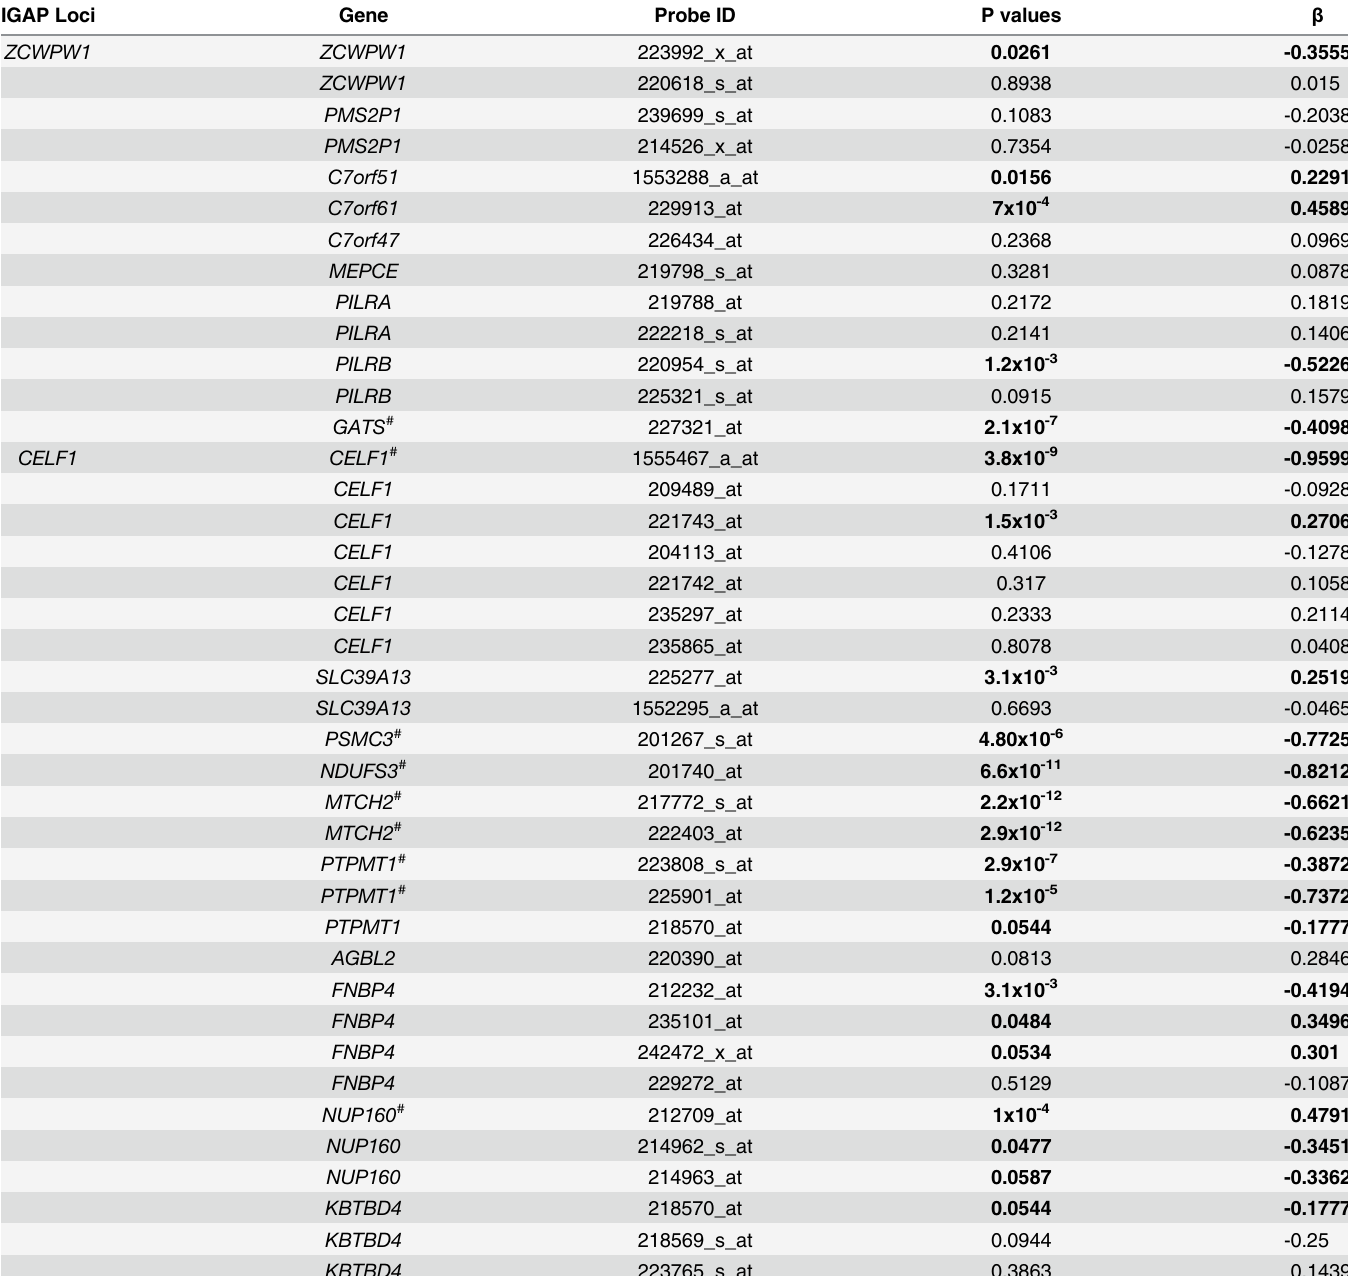
Table 6. Expression of IGAP GWAS loci is associated with disease status in GSE5281. IGAP Loci Gene Probe